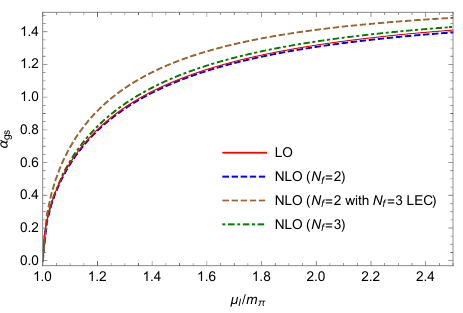
Figure 1 . (cid:11) gs as a function of (cid:22) I =m (cid:25) at LO (red), at NLO with two (cid:13)avors (blue), NLO with three (cid:13)avors (green), and NLO with two (cid:13)avors and three-(cid:13)avor LECs (brown). See main text for